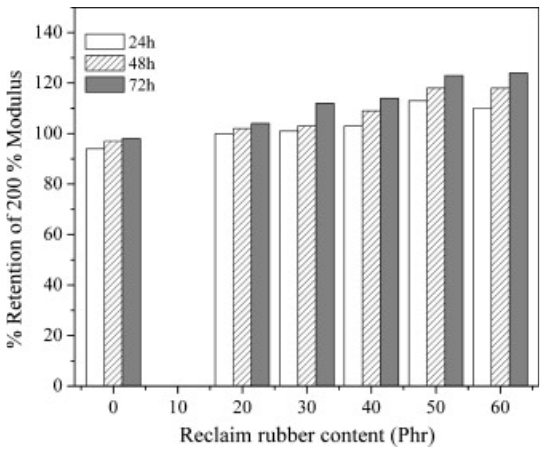
Figure 33. E ff ect of RTR content on the retention of the 200% modulus of NR-PBR / RR blends (reproduced Figure 33. Effect of RTR content on the retention of the 200% modulus of NR-PBR/RR blends